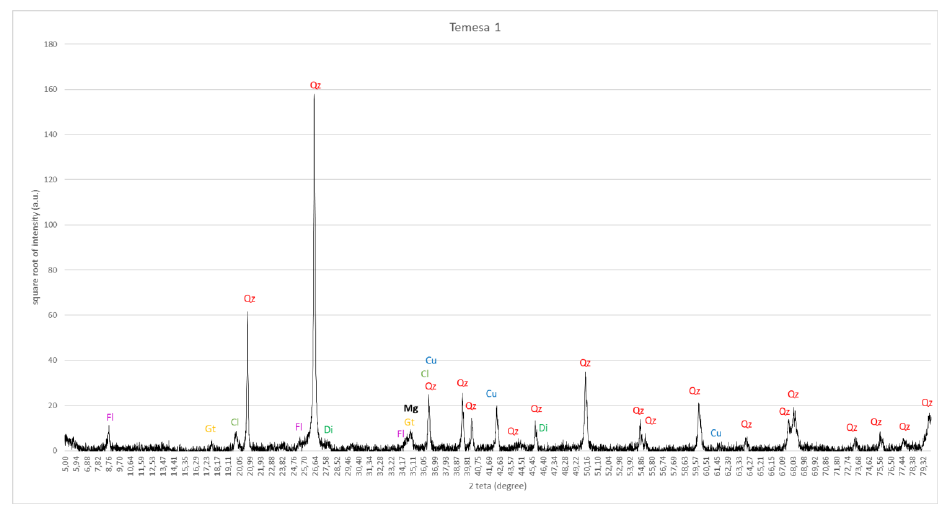
Figure 4. Temesa 1: XRD pattern. Abbreviations: Fl — phlogopite, Gt — goethite, Cl — chloritoid, Qz — quartz, Di — digenite, Mg — magnetite, Cu — cuprite. Square-root intensity scale.